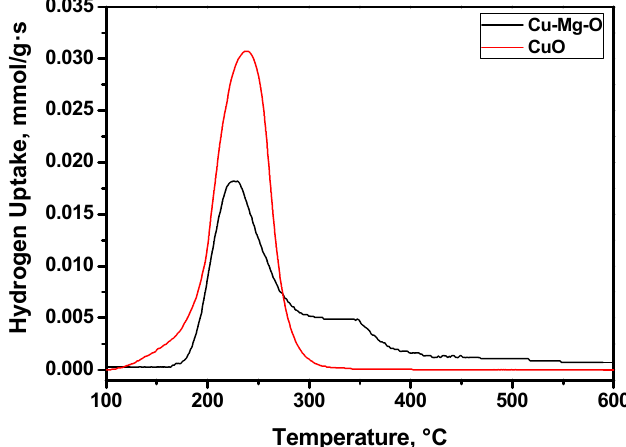
Figure 4. H 2 -TPR profiles for the bulk CuO oxide and prepared Cu-Mg-O system.